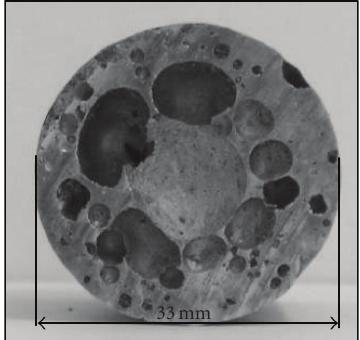
Figure 9: Sample BM, (relative density 0.4).